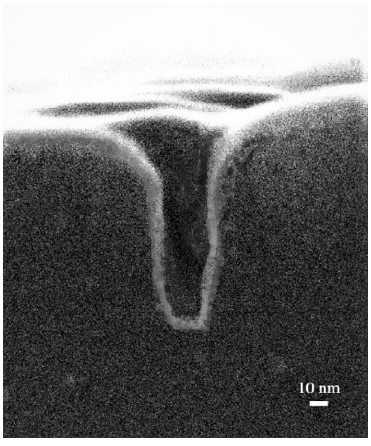
Figure 9. Cross-sectional SEM micrograph of Cu(Mn) film deposited in a via with an aspect ratio of 5 using 60 s terminated OCP